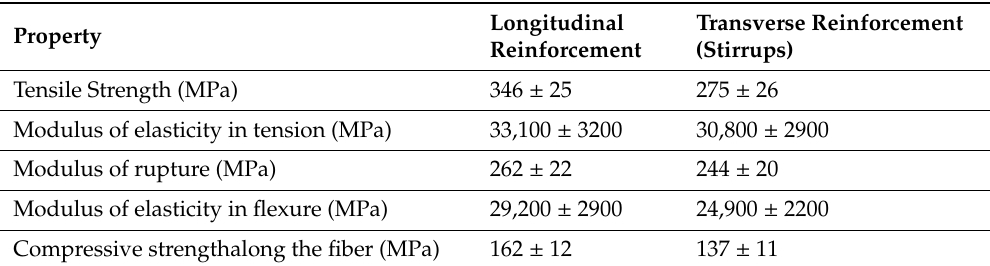
Table 5. Average mechanical properties of bamboo composite reinforcement systems produced in this